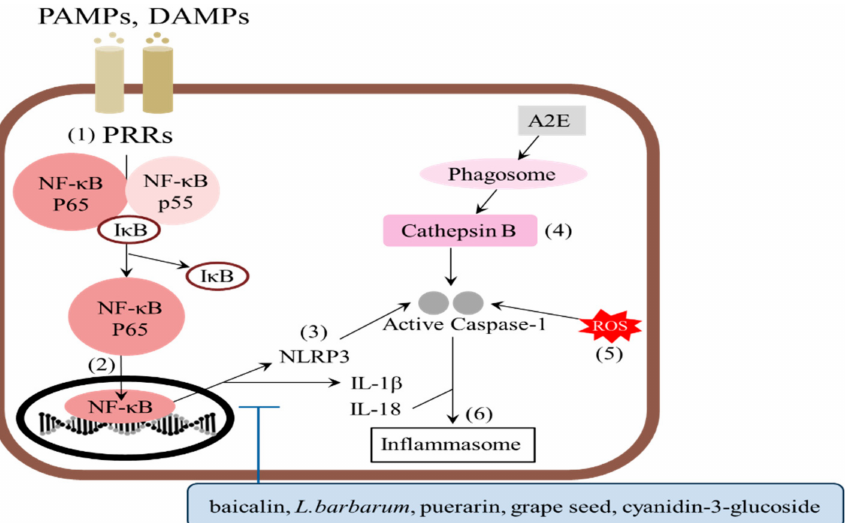
Figure 3. The inflammasome synthesis/activation and the anti-inflammasome effect of natural products. (1) PRRs in the cell membrane bind to PAMPs or DAMPs. (2) After the recognition of PRRs, NF- κ B p65/p55 and I κ B can be separated from each other and NF- κ B p65 enters the nucleus in order to function as a transcription factor for both NLRP3 and pro-IL-1 β (3). (4) A2E produces phagosomes and they release cathepsin B. (5) ROS are generated and stimulate the complex formation of NLRP3, active IL-1 β , and cathepsin B to activate caspase-1. (6) Active caspase-1 binds to IL-18 to produce the inflammasome. Natural products, such as baicalin, Lycium barbarum , puerarin, grape seed, and cyanidin-3-glucoside, can block inflammasome formation to ameliorate inflammation in PRE cells. PRRs, pattern recognition receptors; PAMPs, microbe-derived pathogen-associated molecular patterns; DAMPs, danger-associated molecular patterns; NLRP3, NLR family pyrin domain containing 3; and A2E, N -retinylidene- N